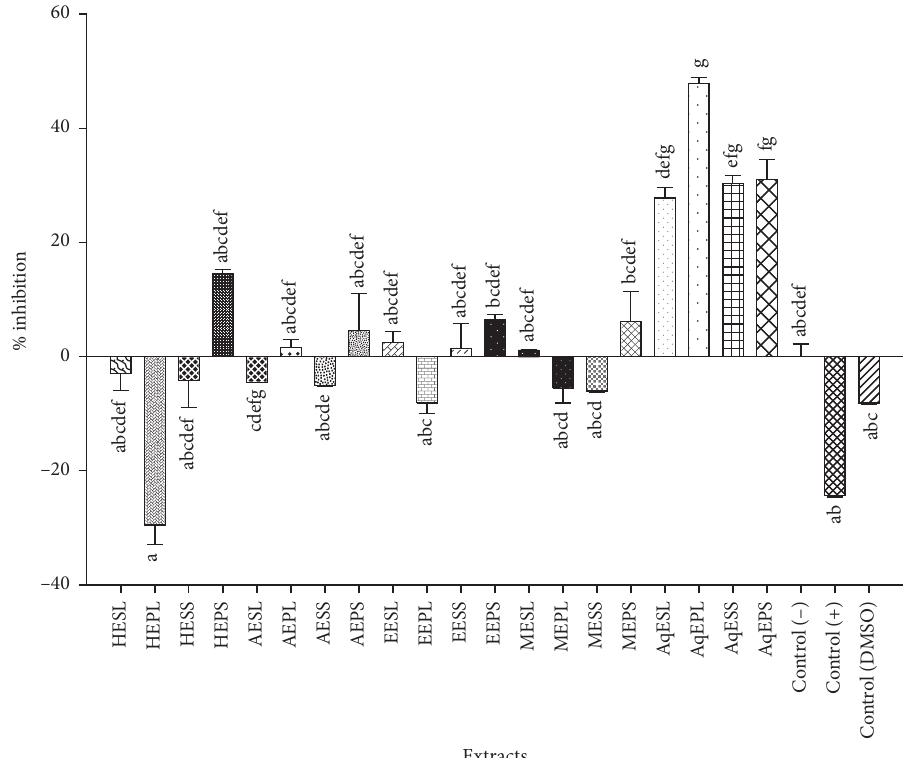
Figure 7: Inhibition percentage at day eight of incubation of the mycelial growth of N. haematococca in the presence of papaya and soursop leaf and seed extracts. Means with the same letter are not significantly different according to Tukey’s test ( P < 0 .